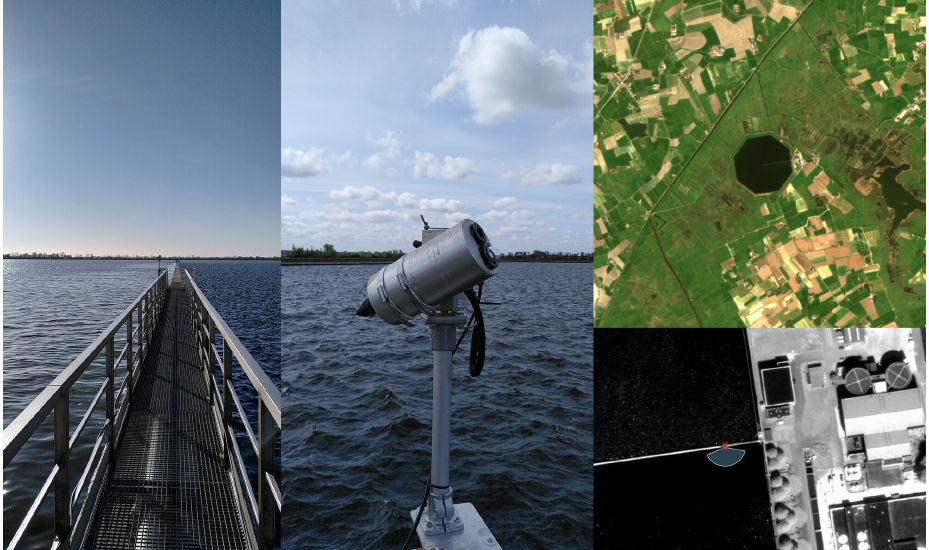
Figure 1. View from the north-east edge of the concrete wall in the Blankaart drinking reservoir ( left ), close-up on the HYPSTAR installed along the railing 30 m from the border edge ( middle ), and true color Sentinel 2A image acquired on 2021-02-04 and processed with ACOLITE [23] with the Blankaart reservoir in the center of the image ( top right ) and the panchromatic GEOEye image acquired on 2019-05-24 ( bottom right ). A red cross indicates the location of the sensor (50.9888°N–2.8352°W). The blue semi-circle shows the orientation of the sensor during the